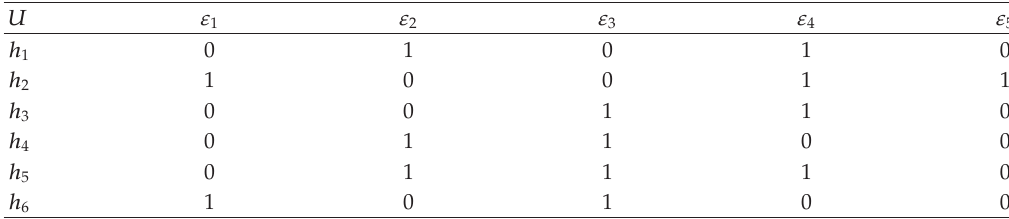
Table 1: Tabular representation of (cid:5) F , A (cid:6)